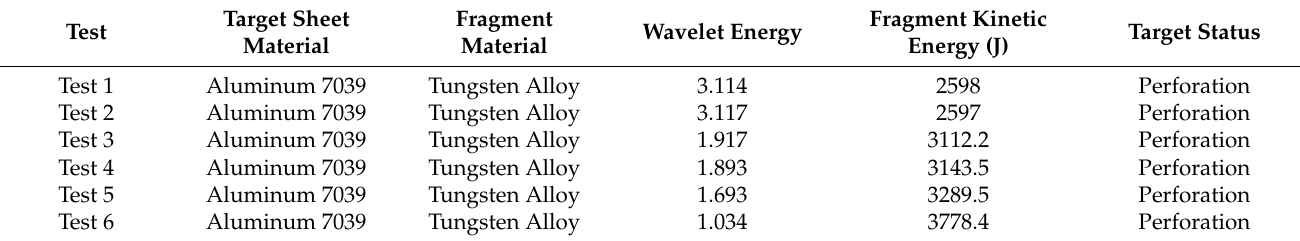
Table 3. Disturbed experiment target sound signal calculation